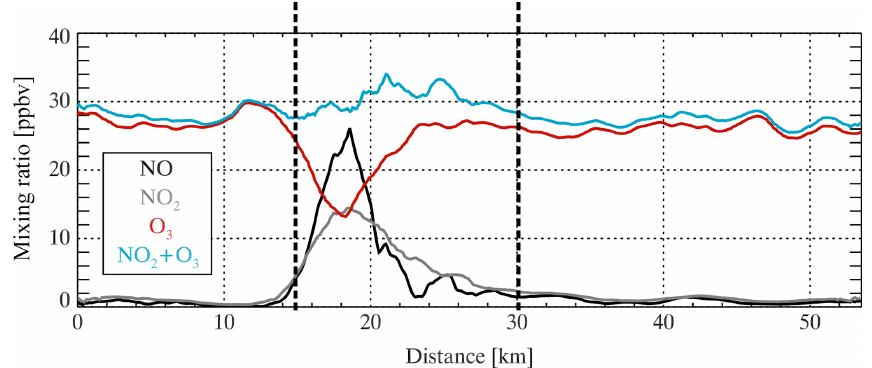
Figure 18. In situ measurements of O 3 , NO, and NO 2 taken from a section of the Convair-580 flight on 23 August 2013 along the east–west direction over the oil sands industry and within the surface boundary layer. The in situ measurements were collected between 11:27 and 11:37 local time (UTC − 6h). The corresponding flight path is shown in Fig. 17. The dashed lines represent the positions of the blue triangles in Fig.